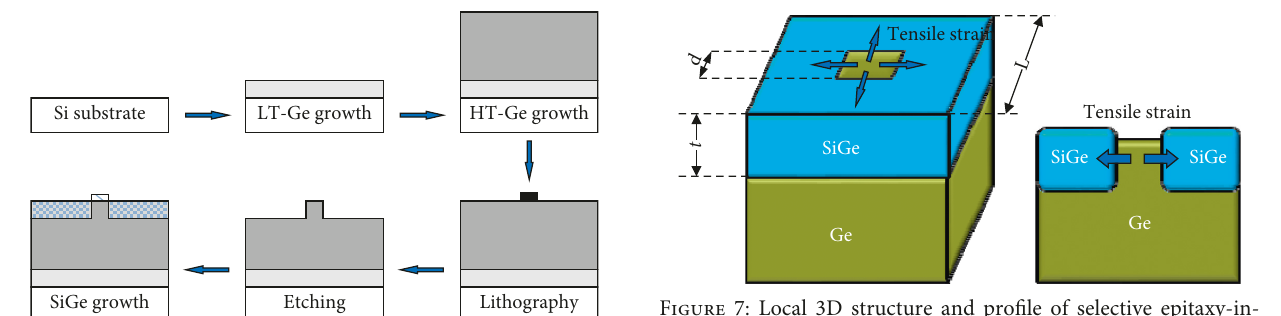
Figure 5: Channel strain simulation of Si PMOS source-drain selective epitaxy. (a) ε (c) ε zz simulation result. (d) ε zz reference result.